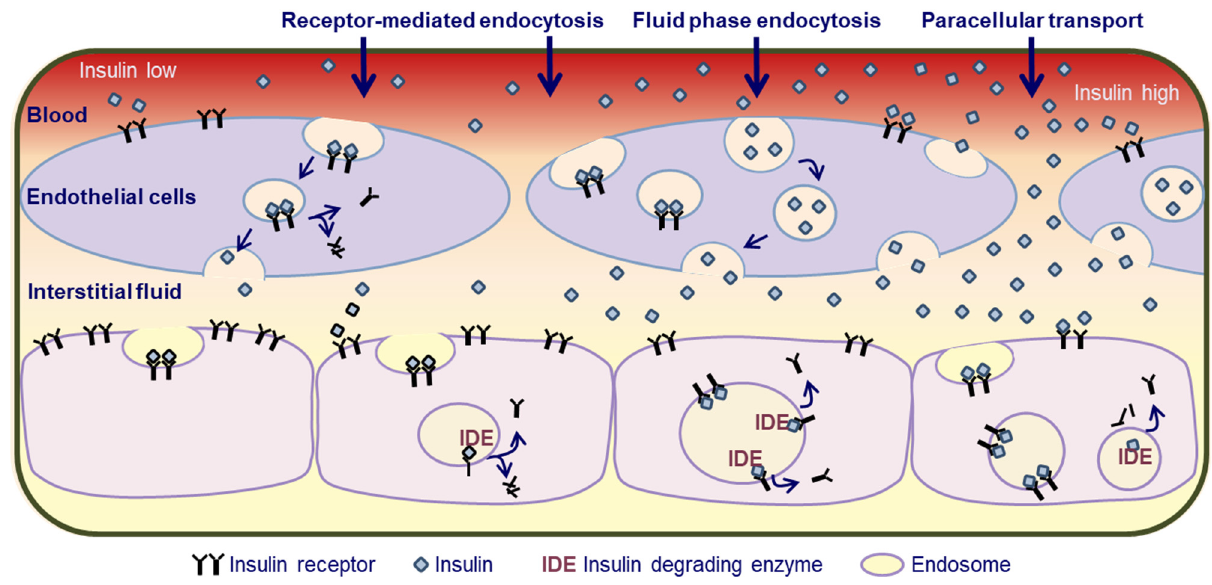
Figure 2. Insulin transport across the endothelium and cellular insulin uptake. Insulin must first pass through the endothelial cell layer of capillaries into the interstitium. The liver sinusoidal endothelial cell layer is fenestrated and highly permeable to insulin, allowing free flow of insulin towards hepatocytes. In skeletal muscles and adipose tissue, insulin crosses the tight endothelial cell layer via receptor-mediated endocytosis-exocytosis, fluid-phase transport, and paracellular transport. Receptor-mediated transcellular transport represents the key route of entry when blood insulin concentration is low and fluid-phase transcellular transport and paracellular transport take over when blood insulin concentration is high. Once in the interstitium, insulin binds to insulin receptors on parenchymal cells, which causes the translocation of the insulin–insulin receptor complex into the cytosol via endocytosis. Insulin is degraded inside the endosomes by insulin degrading enzyme and the receptors start to return to the cell surface.